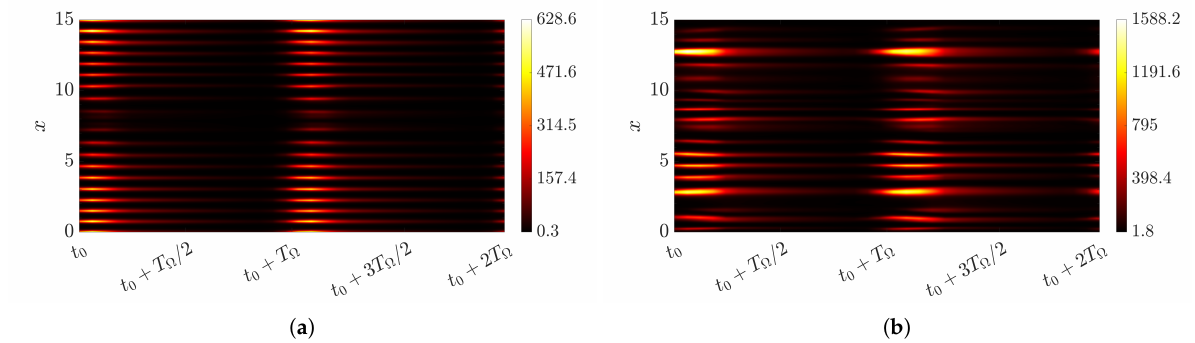
Figure 8. Color field of tr ( ˜ τ ) as a function of the time and the x coordinate in the center of the cavity. 0 < x < 15, y = 0.5, z = 7.5. Numerical simulation with AR = 15, Pr g = 8, Ω = 25, ξ = 0.5, ϑ = 0.1, and Ra ω = 4000. ( a ) Sinusoidal and ( b ) pulse